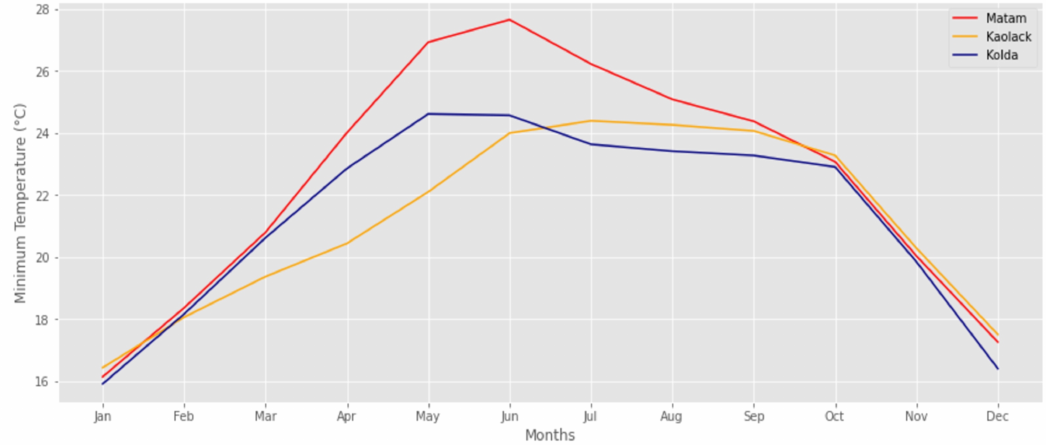
Figure 9. Monthly average Minimum Temperature for Matam, Kaolack and Kolda (1982–2020).